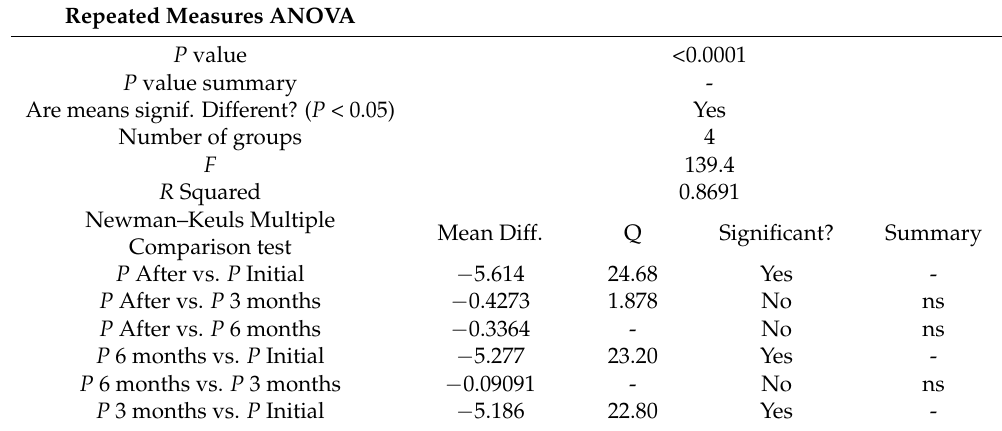
Table 2. Repeated measures ANOVA and Newman–Keuls multiple comparison test between all the groups.